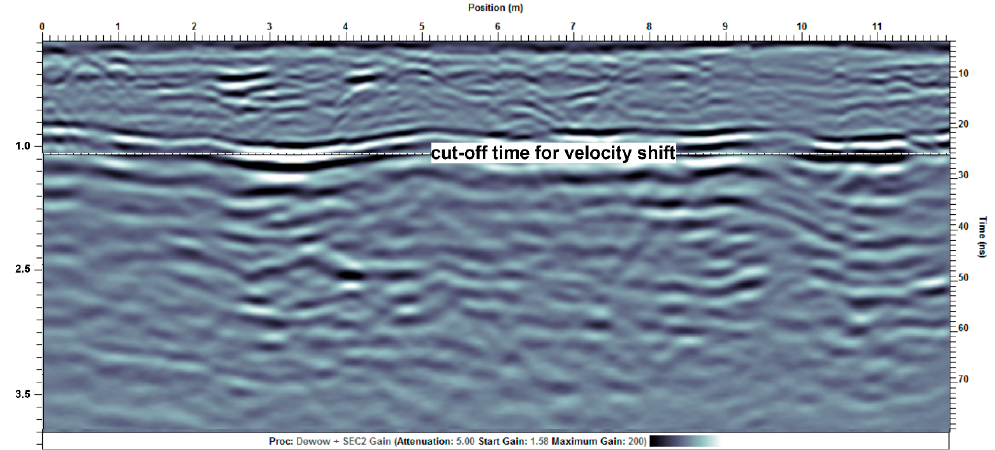
Figure 8. Profile processed as a two-velocity medium. The average velocities of both the frozen and active layer from the same profile shown in Figure 7 were used to produce the above profile with accurate depth estimates for both layers. Depths in the frozen layer are tens of centimeters more than estimated with the active layer velocity alone. The profile above has also migrated using the velocity of the frozen layer. Note that the majority of diffraction tails have been reduced or eliminated when compared to the previous figure.